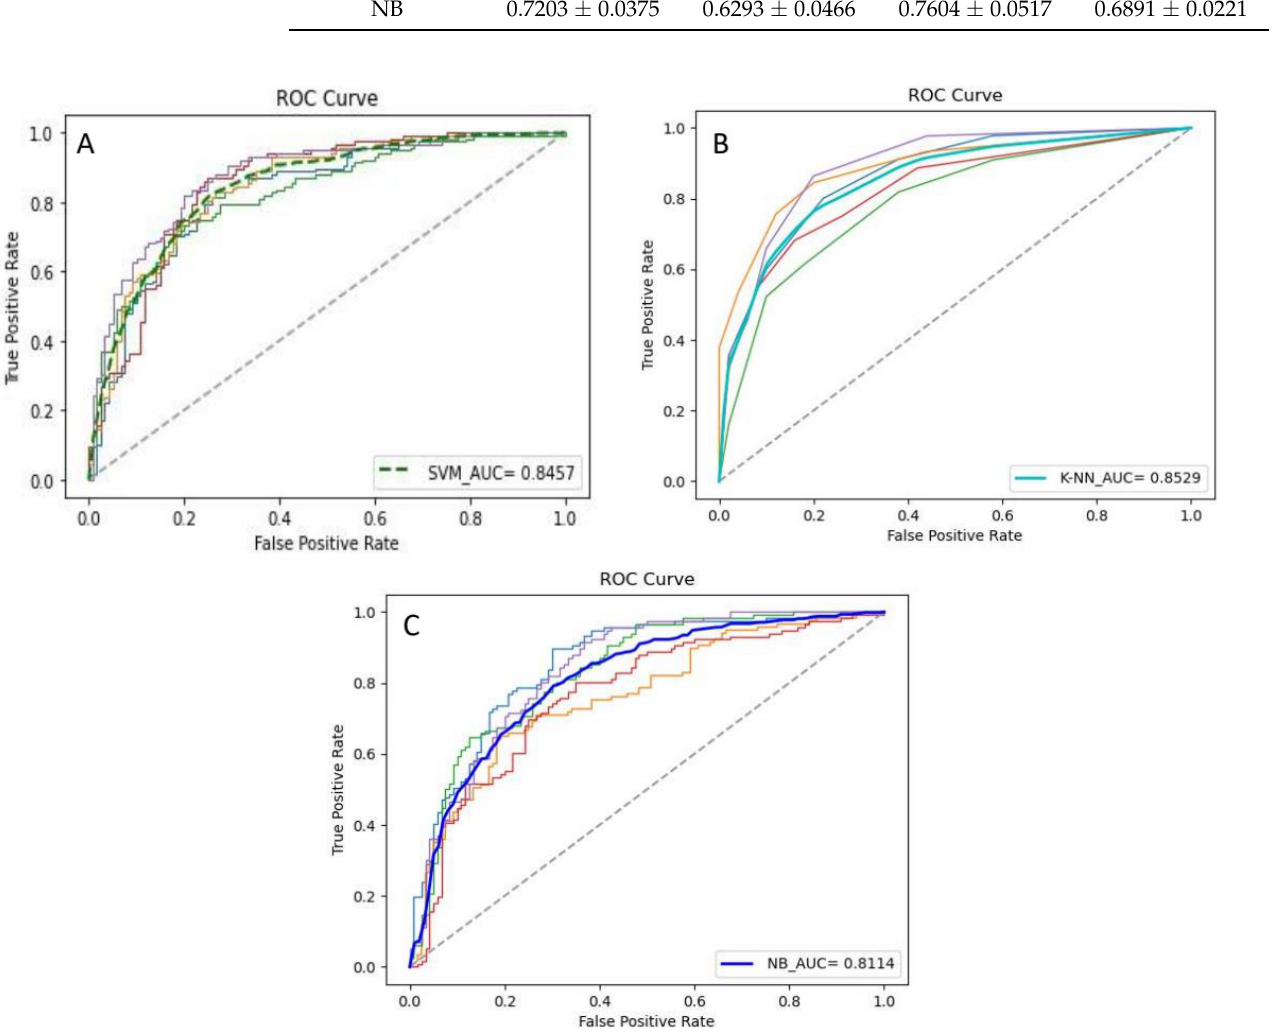
Figure 7. ROC curves and corresponding AUC values of the previous models. ( A ) is the ROC curves and AUC value of SVM; ( B ) is the ROC curves and AUC value of K-NN; ( C ) is the ROC curves and AUC value of NB.